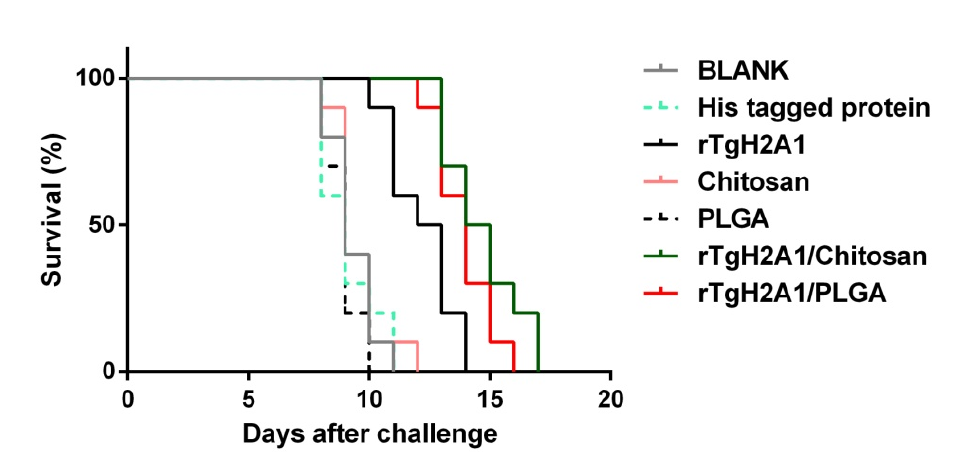
Figure 9. Protection of nanoparticle-immunized mice against acute T. gondii infection. Two weeks after the last immunization, ten mice from each group were intraperitoneally injected with 200 tachyzoites of the highly virulent T. gondii RH strain. Results were analyzed by the Kaplan–Meier test, and compared based on log-rank/Mantel–Cox model.